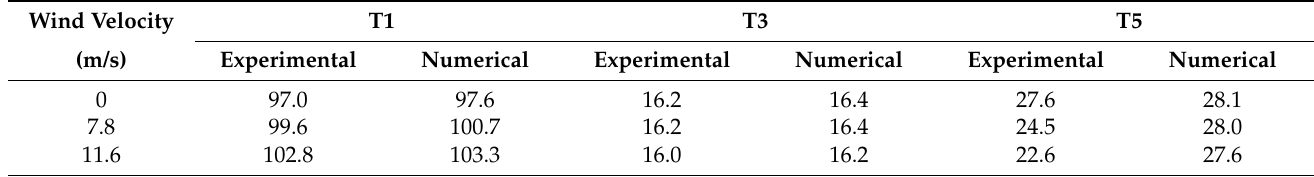
Table 5. Surge, heave and pitch natural periods for each wind condition (without trim adjustment). Wind